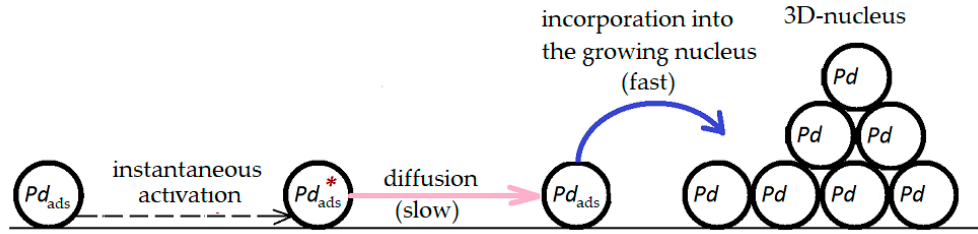
Figure 4. A scheme of the 3D nucleation of palladium during its phase transformation during anodic selective dissolution of the Cu–Pd alloy.